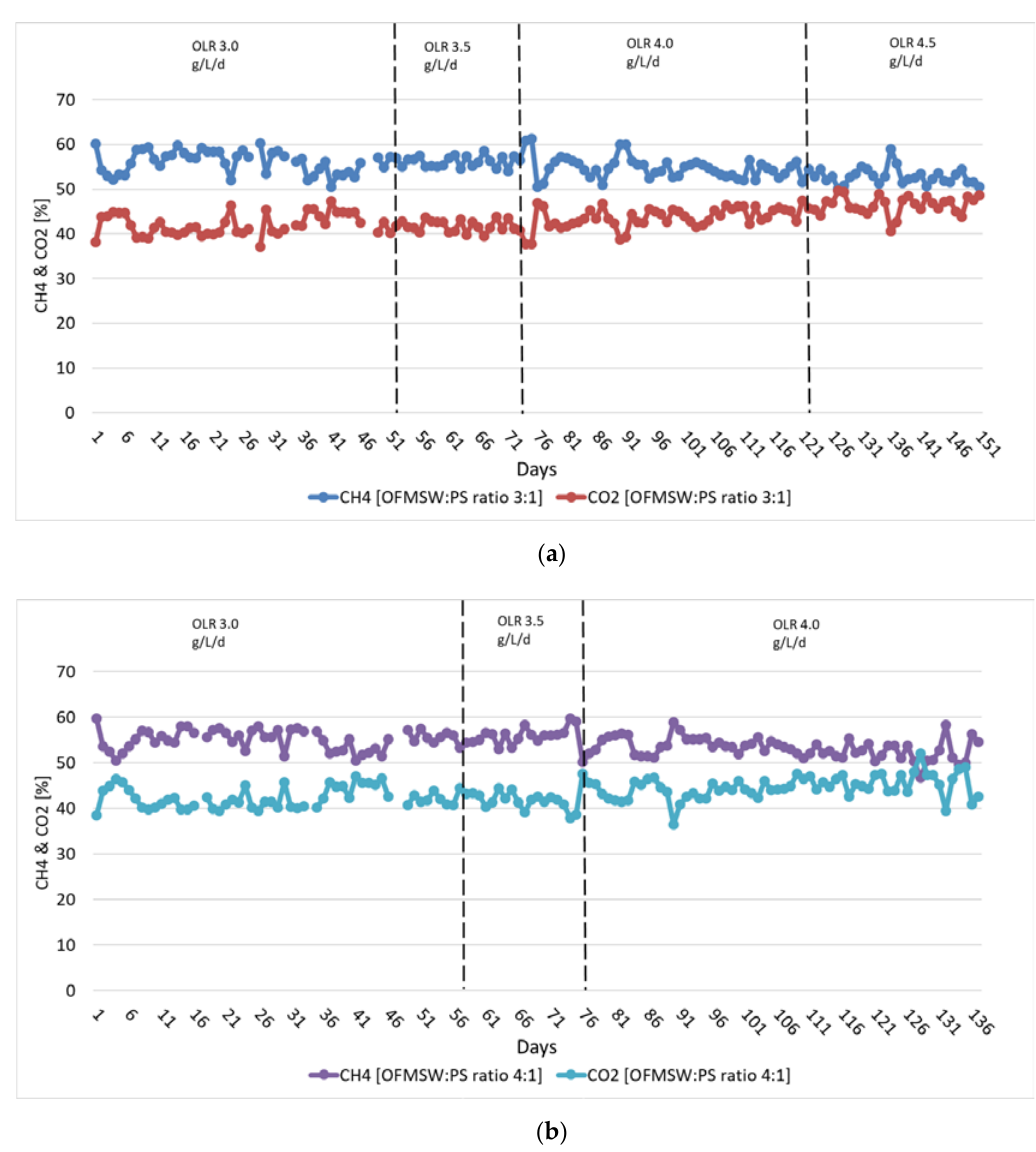
Figure 3. Biogas composition (CO 2 and CH 4 content) obtained at higher OLR:s and with OFMSW:PS ratio of 3:1 ( a ) and 4:1 ( b ). The OLR:s are presented at the top of each figure.